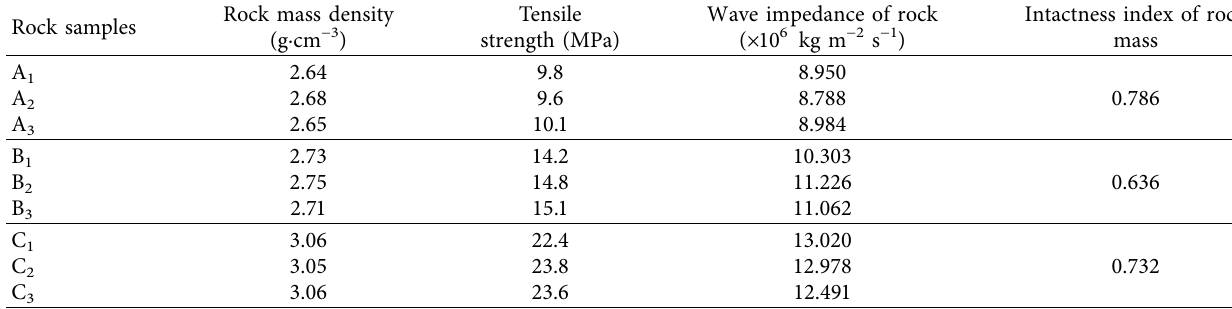
Table 10: Parameters of rock samples in the engineering area. Rock samples